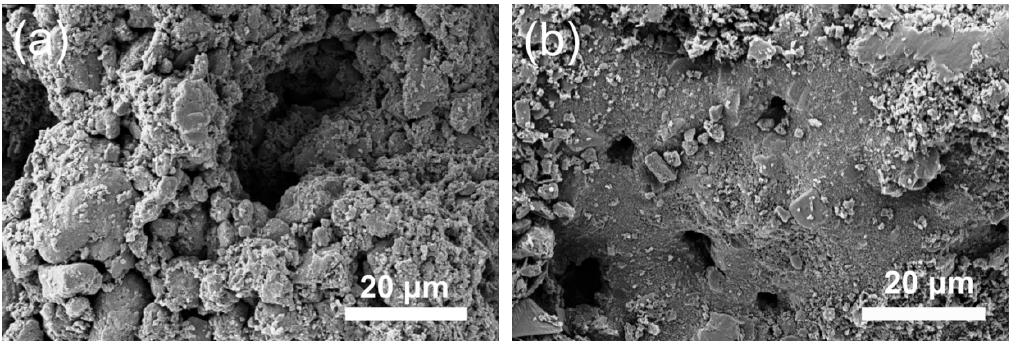
Figure 8. SEM images of char residues ( a ) g-C 3 N 4 -2%, and ( b ) Co/P-C 3 N 4 -2%.